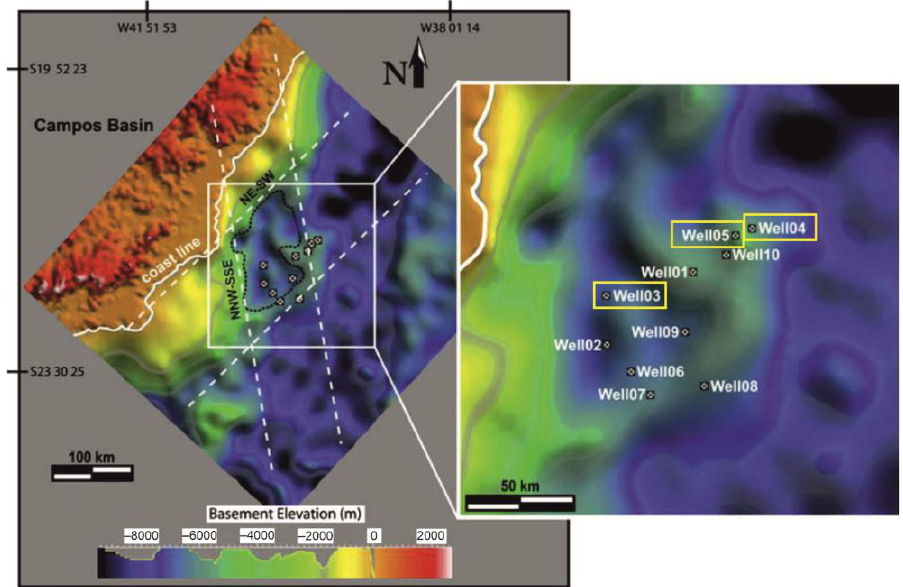
Figure 7. Location of the well cores 03, 04 and 05 used for petrographic analysis of the turbidite reservoirs, respectively, of the Santonian, Campanian and Maastrichtian of Campos Basin